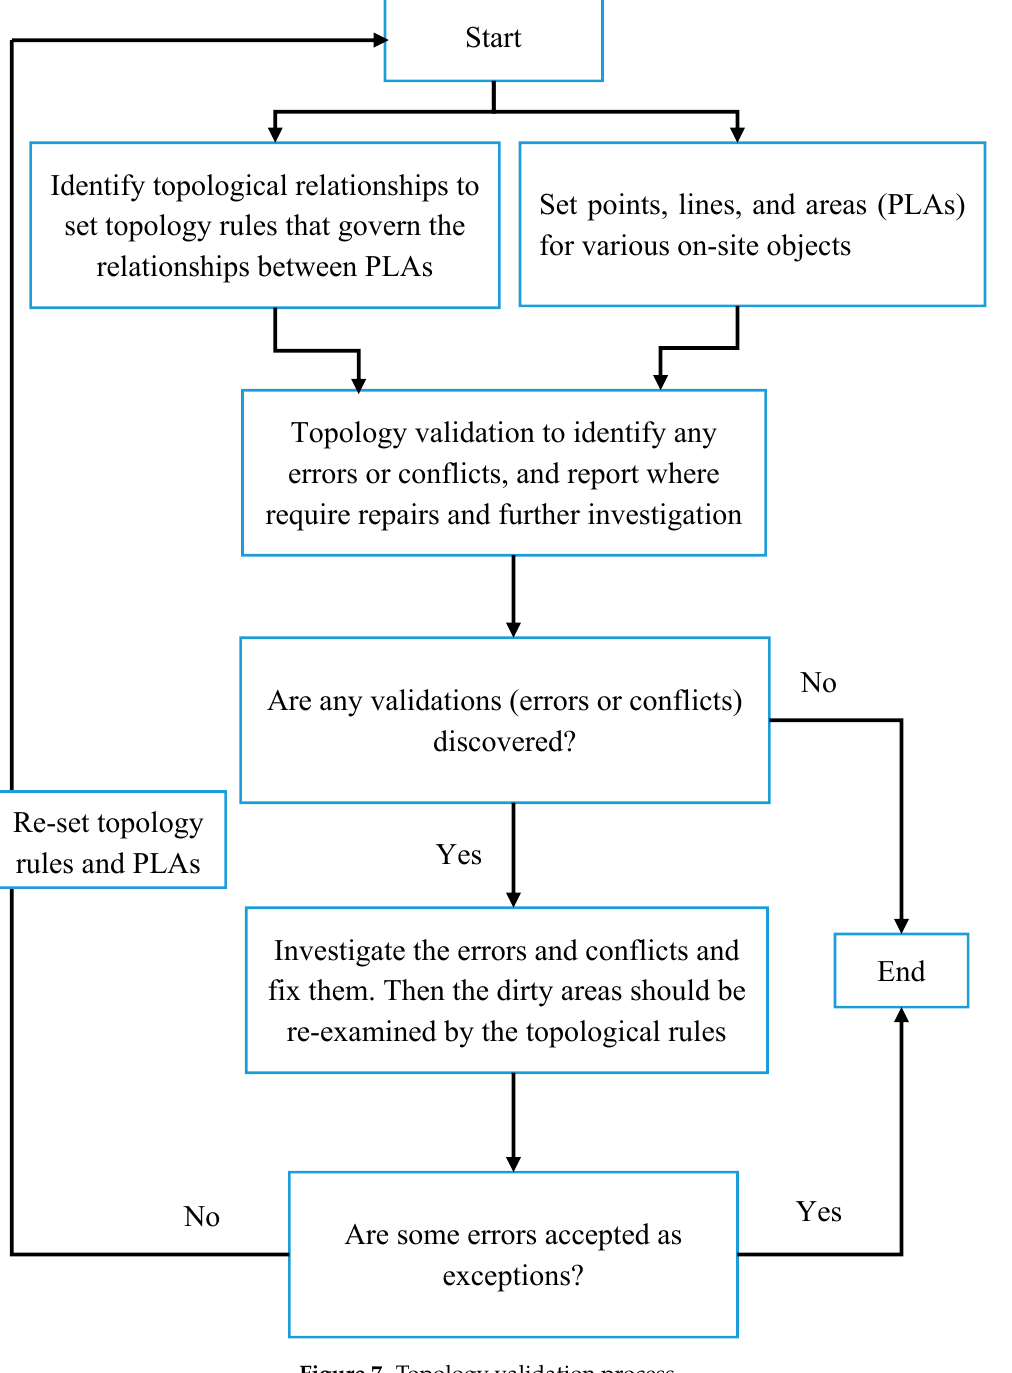
Figure 7. Topology validation process.